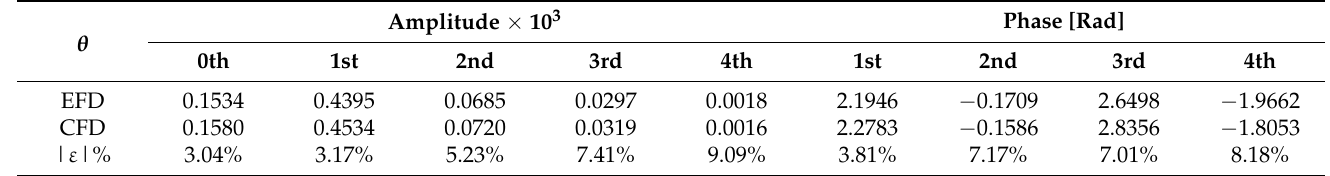
Table 23. Harmonic amplitudes and phases of pitch for the FRxz ϕθ quartering waves